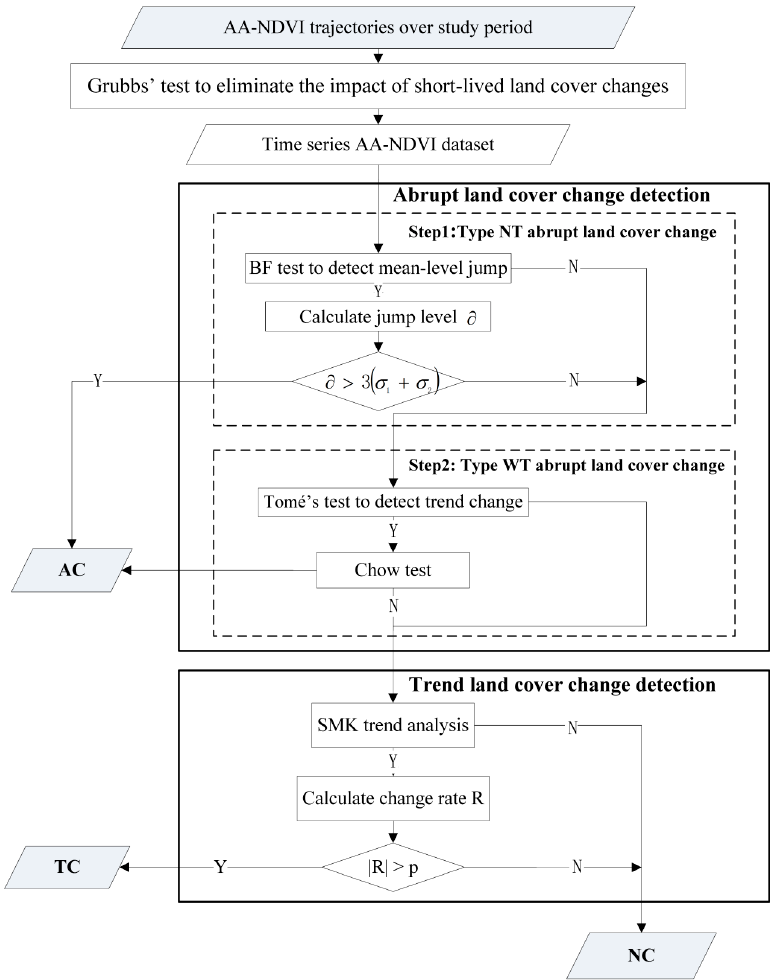
Figure 3. Framework of MTHD method.